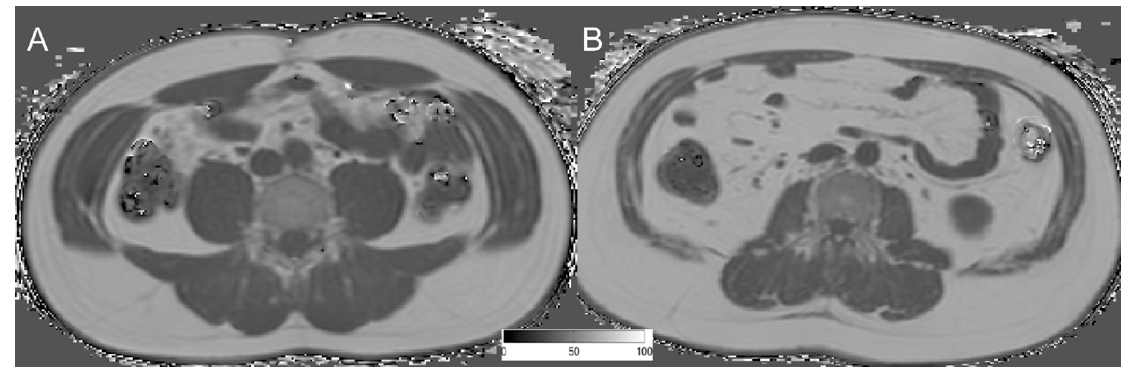
Figure 2. Representative PDFF maps on the level of L4 of a 39-year-old man ( A ) BMI: 24.92 kg/m 2 ; mean PDFF abdominal muscles: 3.152%; mean PDFF psoas muscle: 0.764%; mean PDFF erector spinae: 6.332%; and a 37-year-old man ( B ) BMI: 30.68 kg/m 2 ; mean PDFF abdominal muscles: 17.789%; mean PDFF psoas muscle: 12.678%; mean PDFF erector spinae: 11.386%.